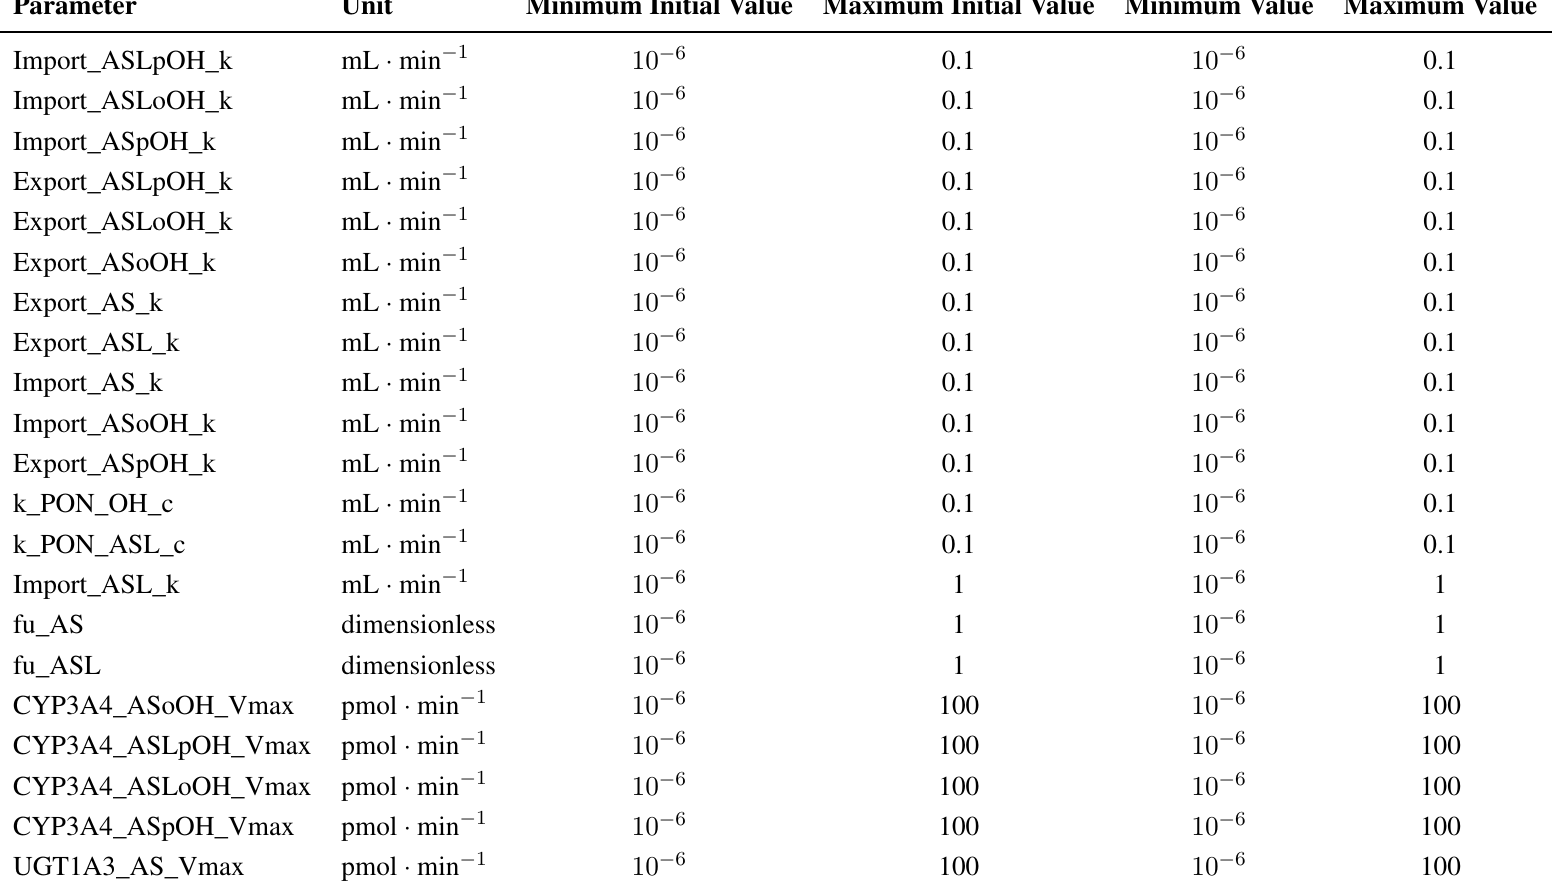
Table 1. Estimated parameters with units, their initial intervals and their intervals throughout parameter estimation for the model by Bucher et al.